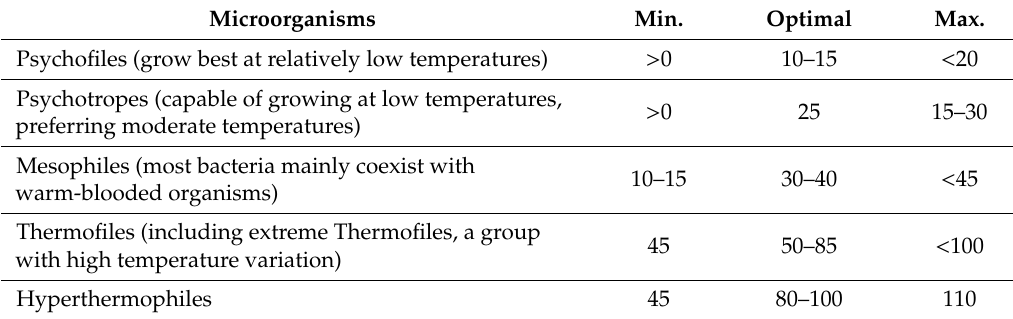
Table 2. Division of organisms according to growth temperature [10,15]. Microorganisms Min. Optimal